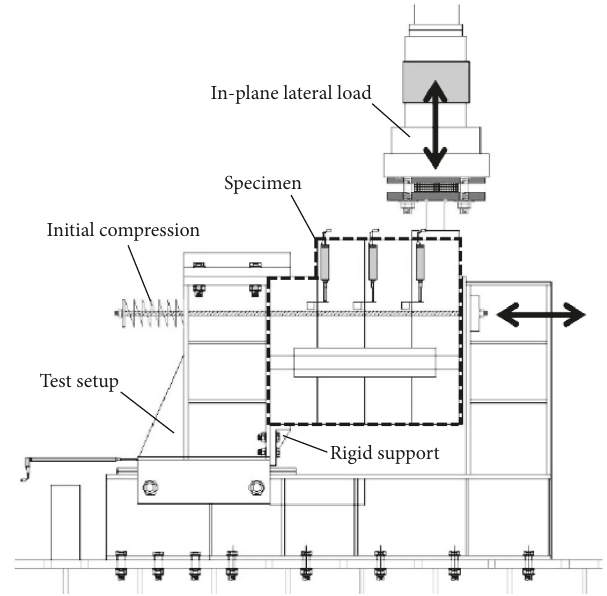
Figure 3: Schematic representation of test setup (front view), in accordance with [12–14].